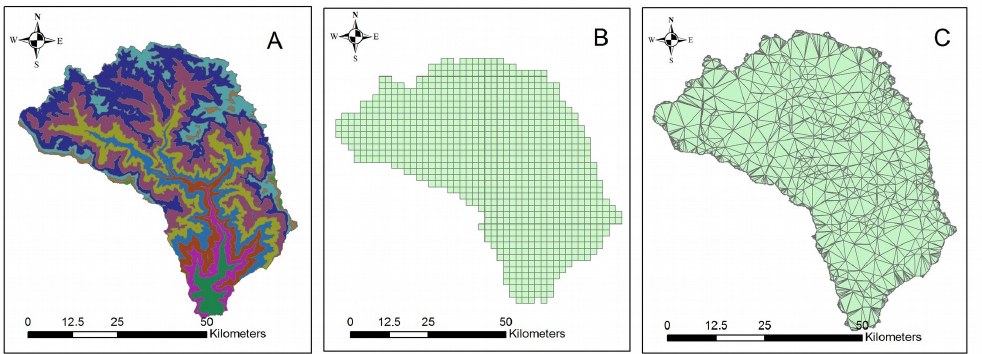
Figure 3. Catchment discretization by ( A ) hypsographic, ( B ) regular space grid, and ( C ) TIN